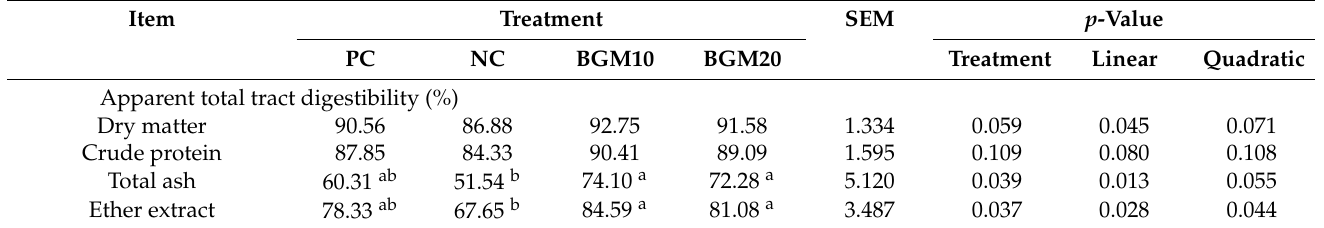
Table 3. Effect of dietary BGM with multienzyme addition on apparent total tract digestibility in weaning pigs 1,2